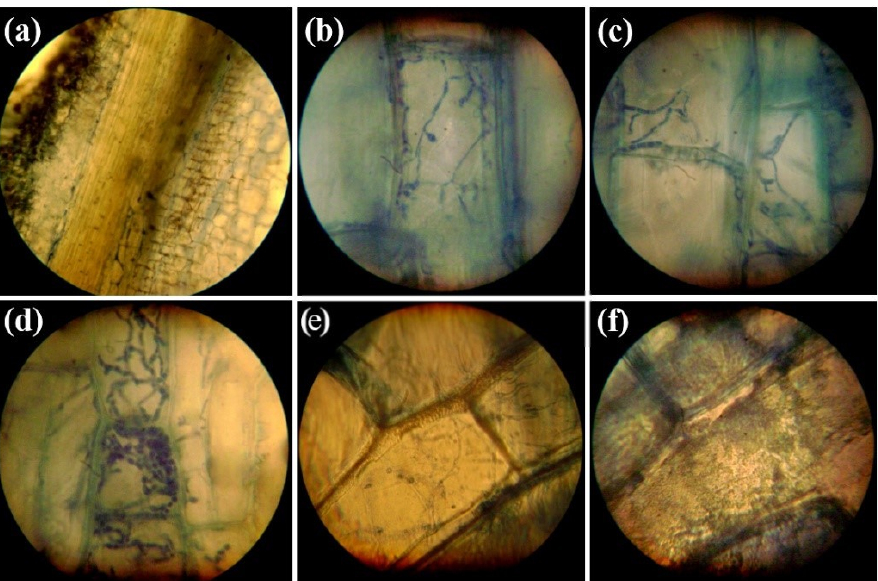
Figure 1. Longitudinal section of the main roots of cucumber plants affected by P. melonis 502 ( a ). Cross section of the main cucumber roots infected with P. melonis 502 ( b – f ). Colonization by the fungus P. melonis 502 of the roots of cucumber plants, which leads to necrosis of the cell wall ( e ). Lysis of root cells of cucumber plants affected by P. melonis 502 ( f ). 900× magnification.